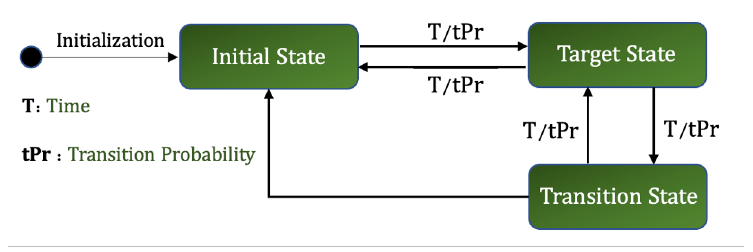
Figure 16. States and Conditions for Situation